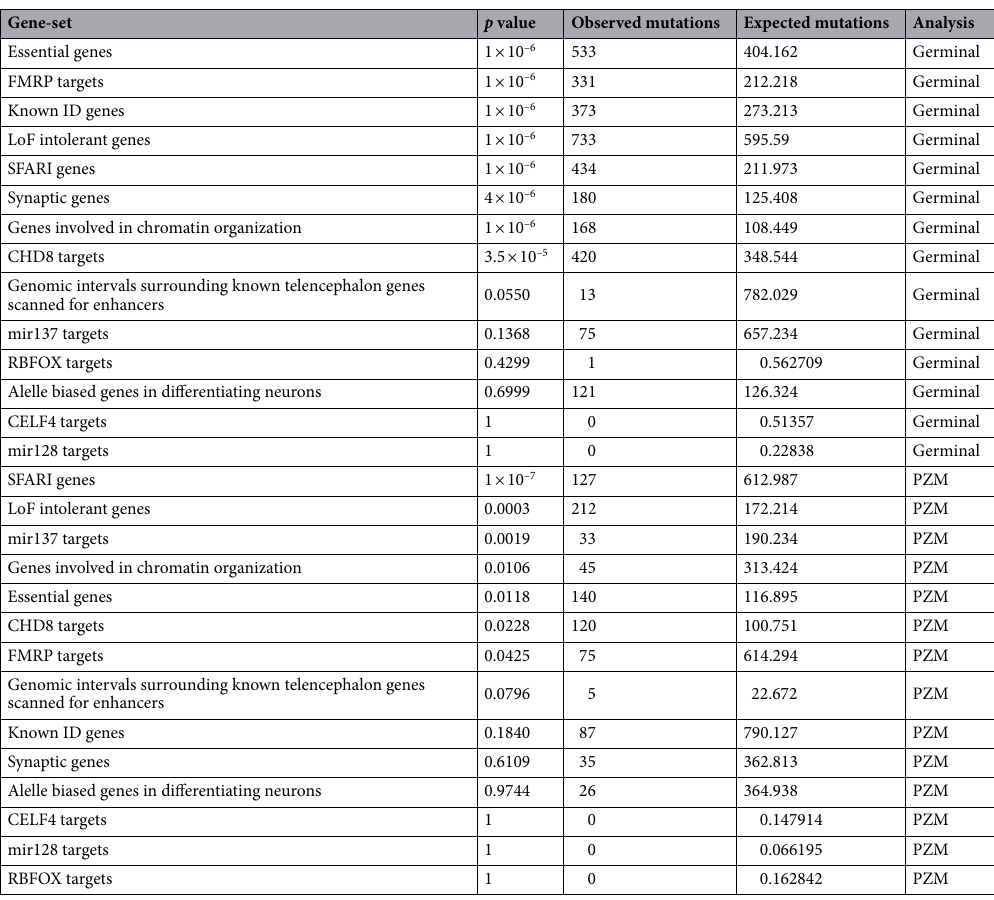
Table 4. Results of the gene-set enrichment analysis for the list of genes harboring germinal DNMs and PZMs (combined cohort).